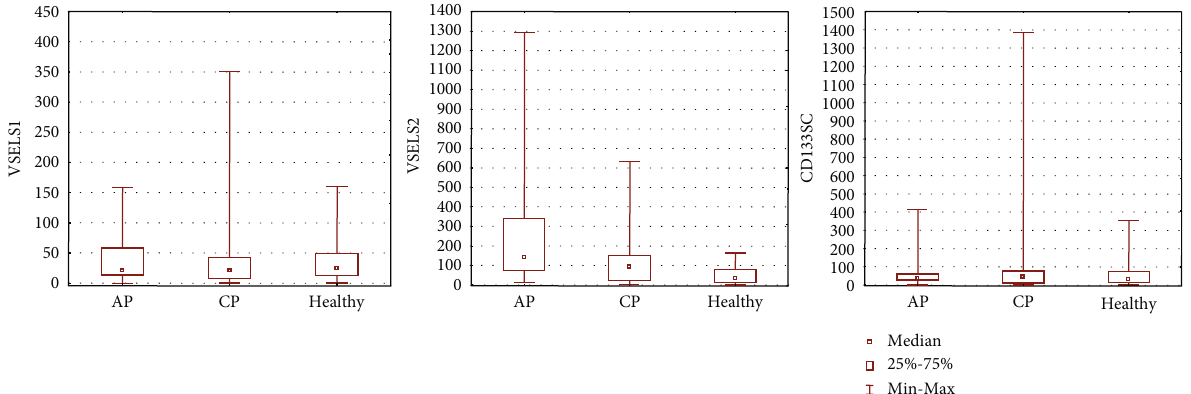
Figure 1: The absolute numbers of circulating cells from the VSELs “ 1 ” , VSELs “ 2 ” , and CD133 + SC subpopulations in the PB of